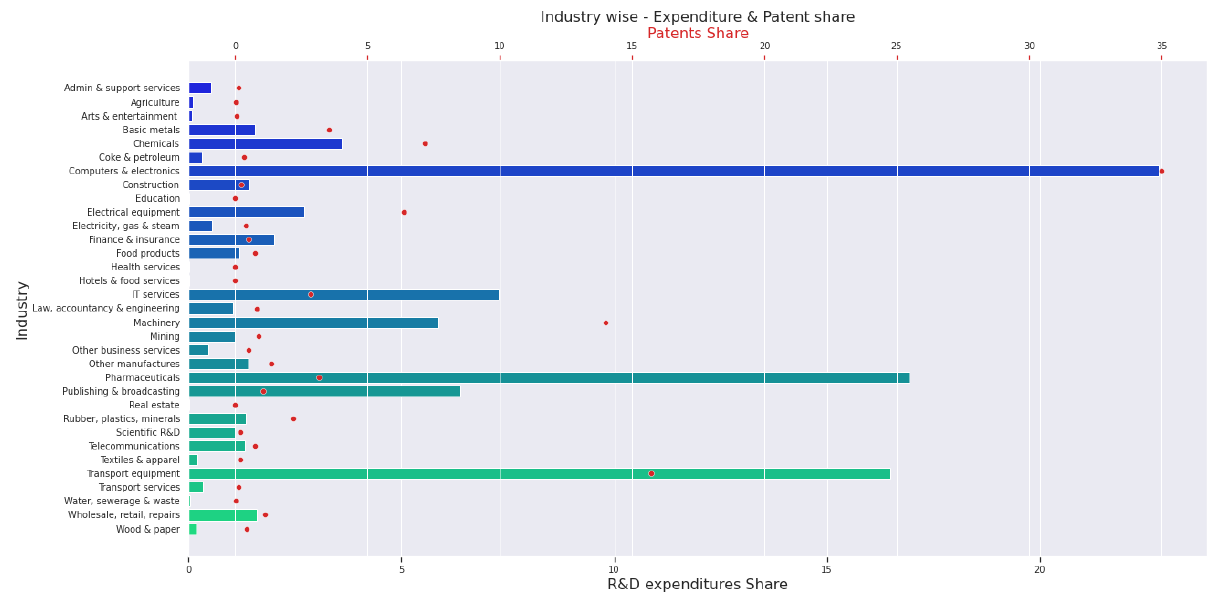
Figure 2. Industry expenditure in R&D and patent share.